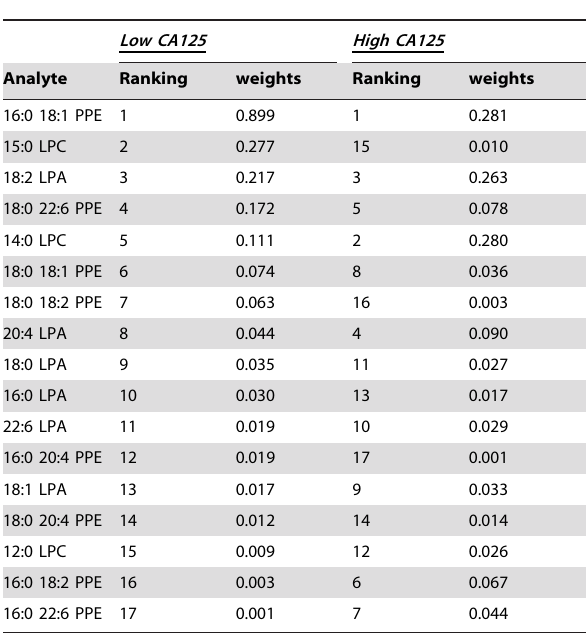
Table 4. The weights generated by Huberized Hinge Support Vector Machine (HHSVM) to indicate the relevance of the biomarkers for classification of benigns and cases for the samples with either low- or high- CA125 levels (CA125 , 35 or CA125 $ 35) in the second step of the development of the two-step